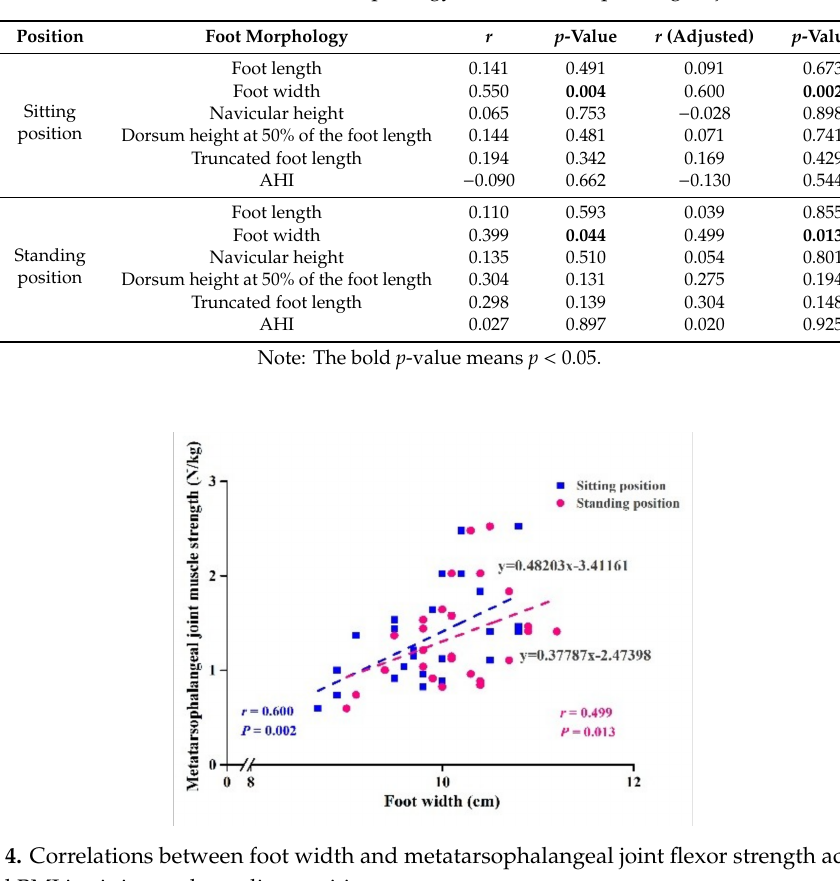
Table 4. Correlation coe ffi cient of foot morphology and metatarsophalangeal joint flexor strength.